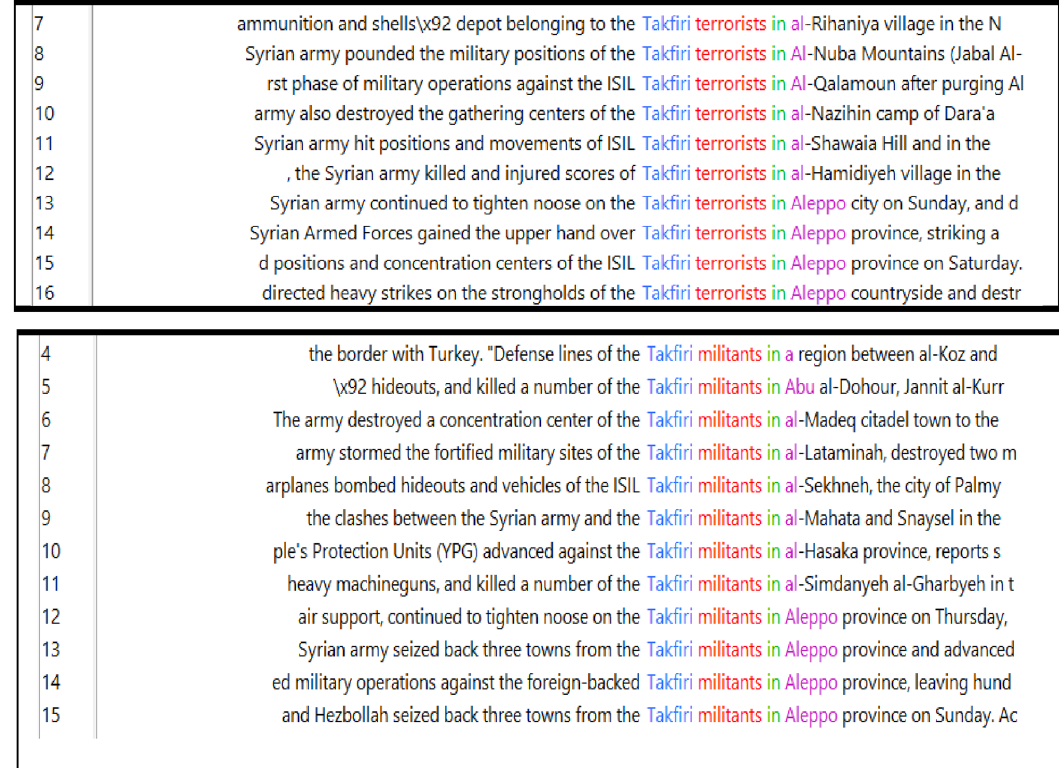
Figure 10: Concordance lines of the patterns Tak fi ri terrorists and Tak fi ri militants